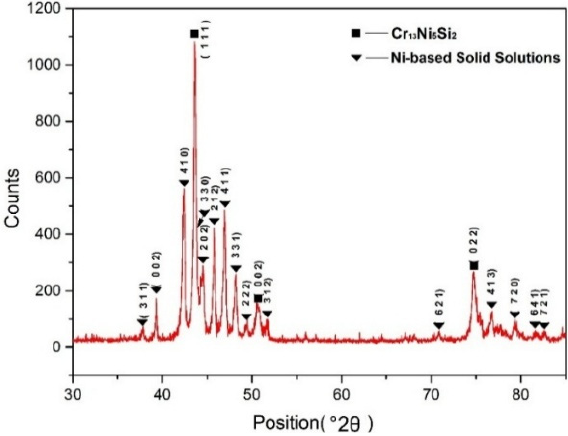
Figure 11. XRD spectra of the Cr 13 Ni 5 Si 2 composite coating.